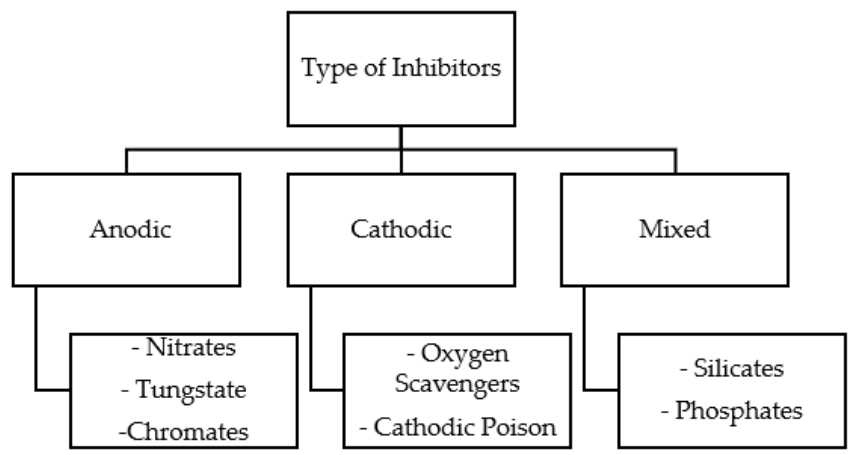
Figure 1. Types of corrosion inhibitors.